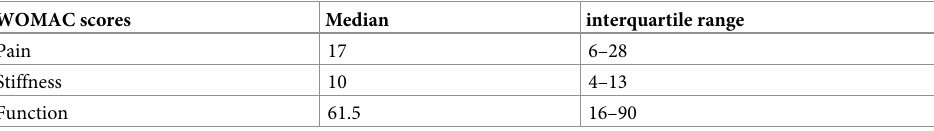
Table 1. WOMAC score profile of participants (n = 68). The table shows median and IQR values for each domain of Pain, Stiffness and Function. WOMAC